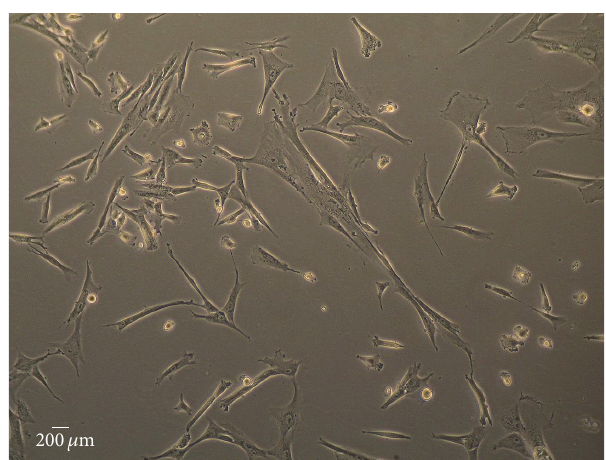
Figure 1: HMSCs from Wharton’s jelly exhibiting a mesenchymal- like shape with a flat polygonal morphology after 4 days of in vitro culture (magnification: